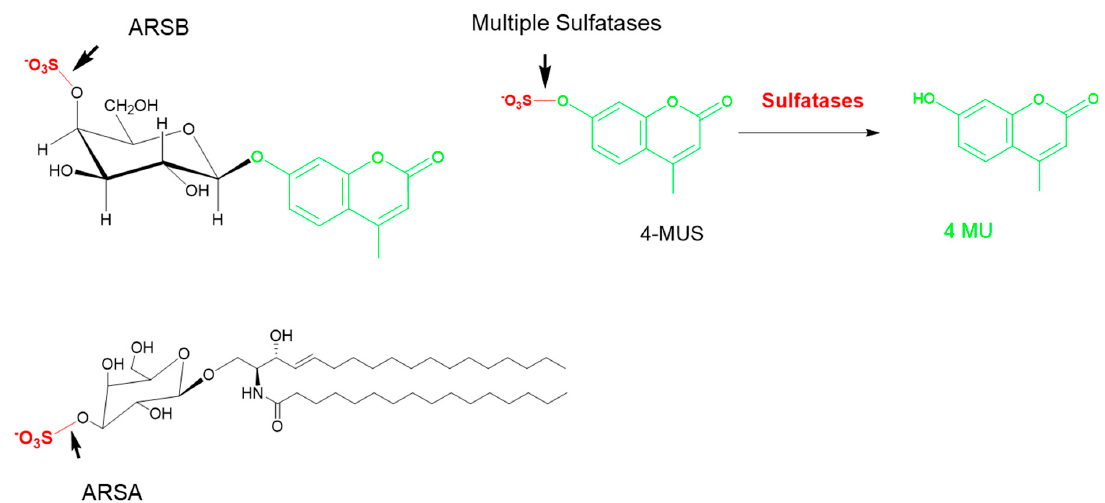
Figure 6. The common methylumbelliferyl sulfate (MUS) substrate. Multiple sulfatases are able to cleave the sulfate group in 4-MUS, as the only commonality is the sulfate group. Examples of specific substrates for ARSA (cerebroside galactosyl sulfate) and ARSB (GalS) are shown on the left. ARSA: arylsulfatase A; ARSB: N -acetyl galactosamine 4-sulfatase.